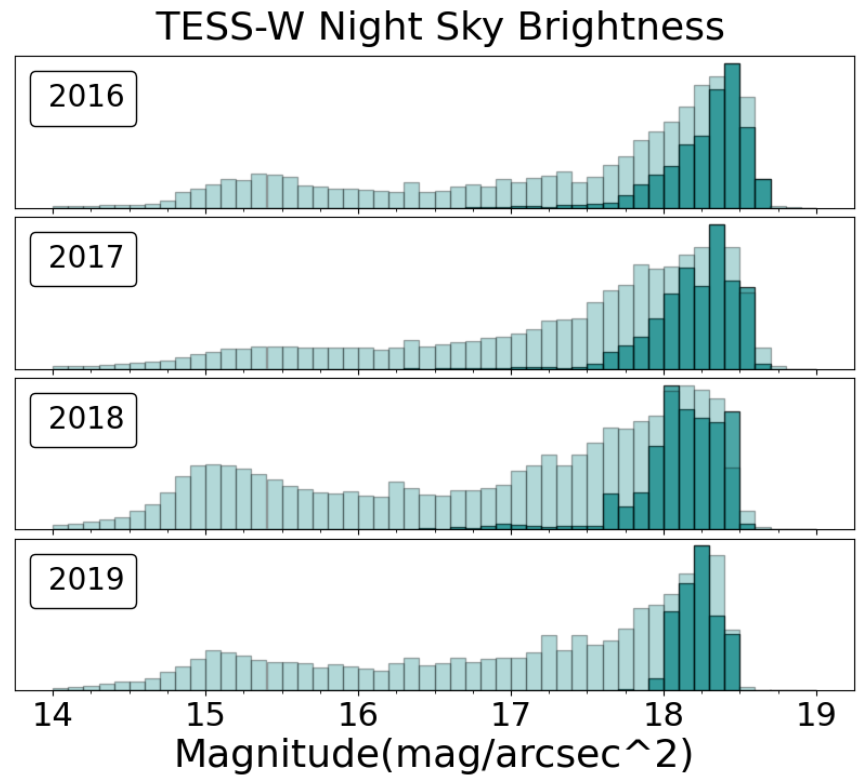
Figure 13. TESS-W magnitude by year. Darker bars represent the result for filtered data (no moon over the horizon and no clouds) and lighter bars for unfiltered data (with moon and clouds). All measures exclude twilight.